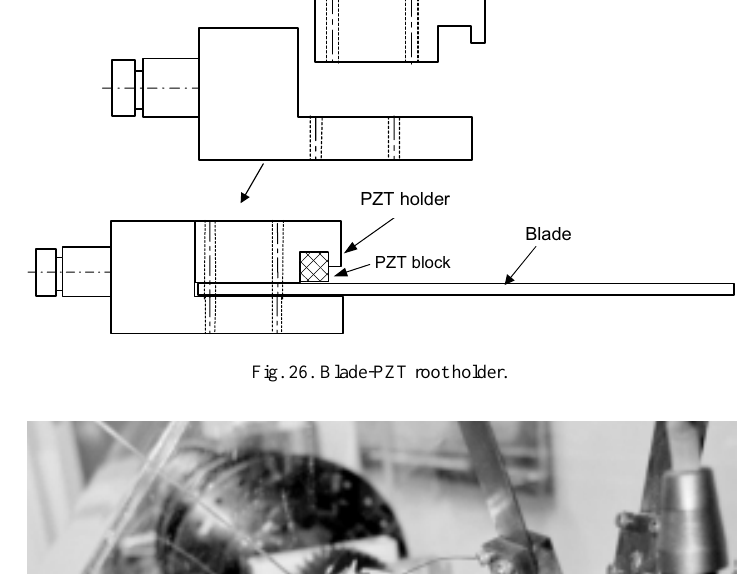
Fig. 26. Blade-PZT root holder.